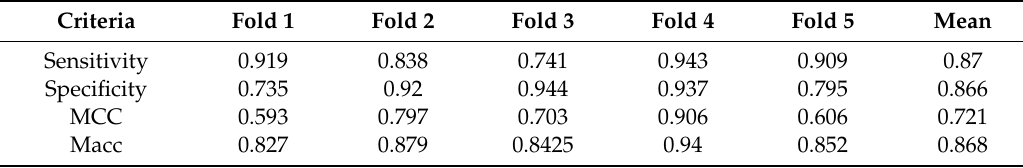
Table 2. Classification performance of the proposed method based on five-fold